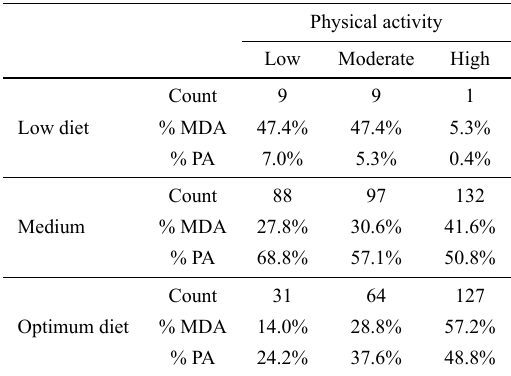
Table 2. Relationship between physical activity and adherence to Mediterranean diet ( p < 0.001).